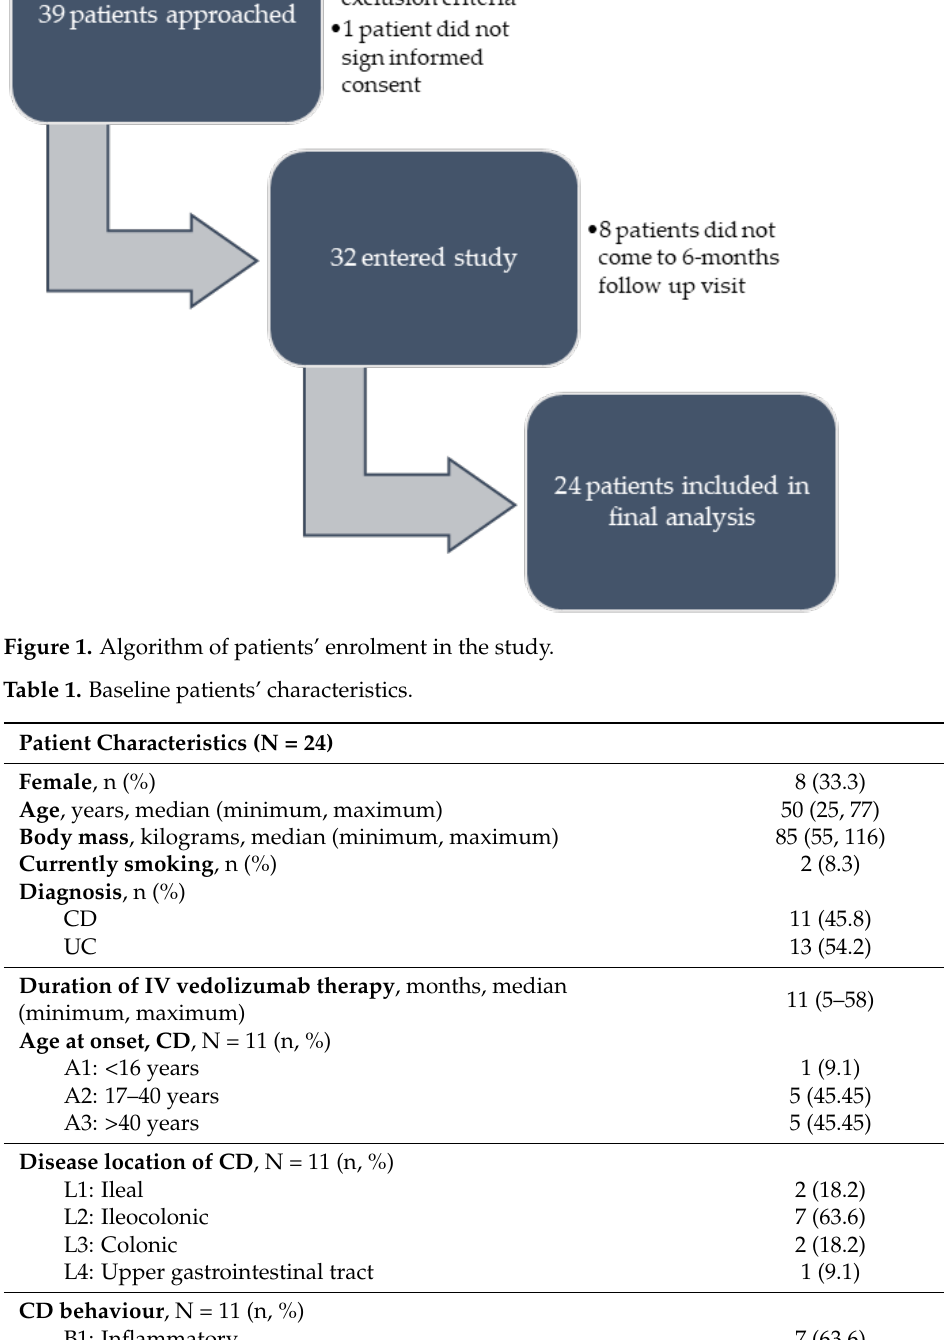
Figure 2. Proportion of patients in clinical remission, remission defined by fecal calprotectin (FC) <